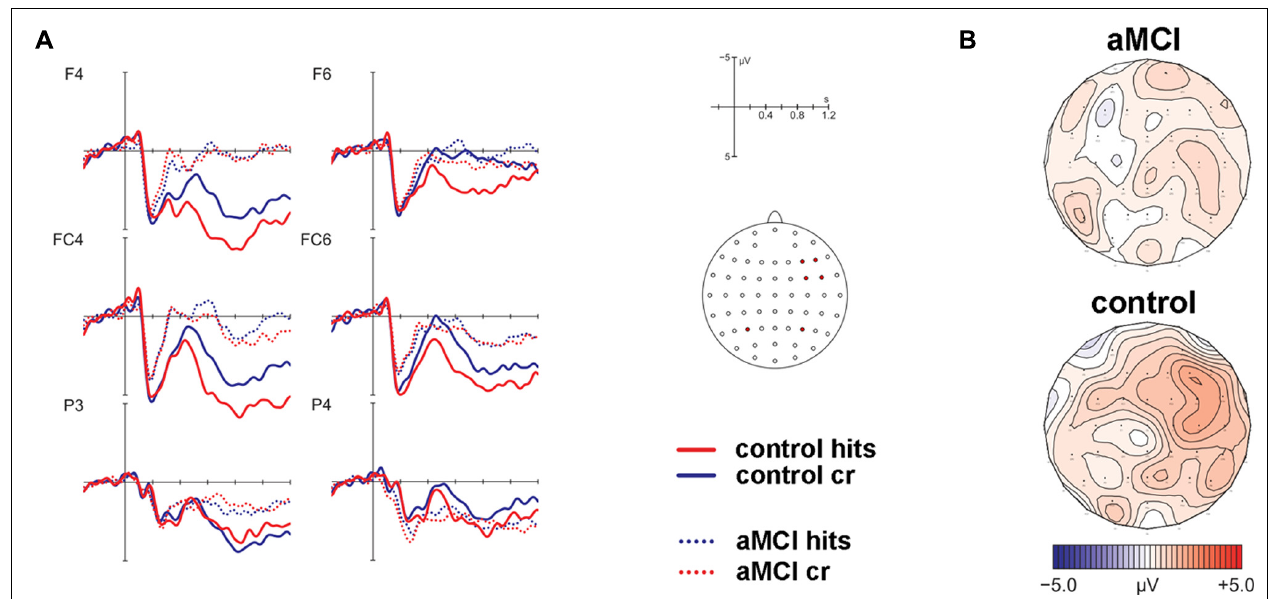
color, correct rejections (cr) in blue color. At posterior electrodes (exemplified at positions P3/P4), there was no significant effect for hits vs. cr. The corresponding topographic maps are depicted in panel (B) for the contrast hits > cr in the time window 450–600 ms post-stimulus